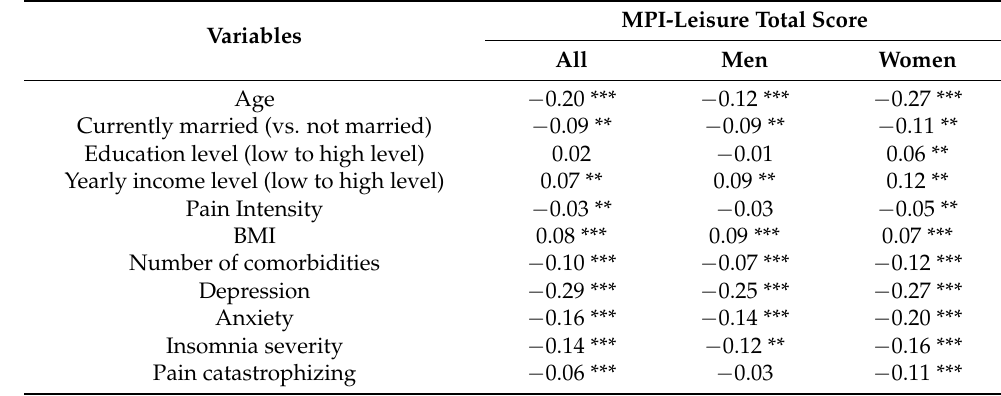
Table 2. Pearson correlations of participation, psychological distress, BMI, comorbidities, pain intensity, and age for the whole sample and stratified by gender. MPI-Leisure Total Score Variables All Men Women Age − 0.20 *** − 0.12 *** − 0.27 *** Currently married (vs. not married) − 0.09 ** − 0.09 ** − 0.11 **